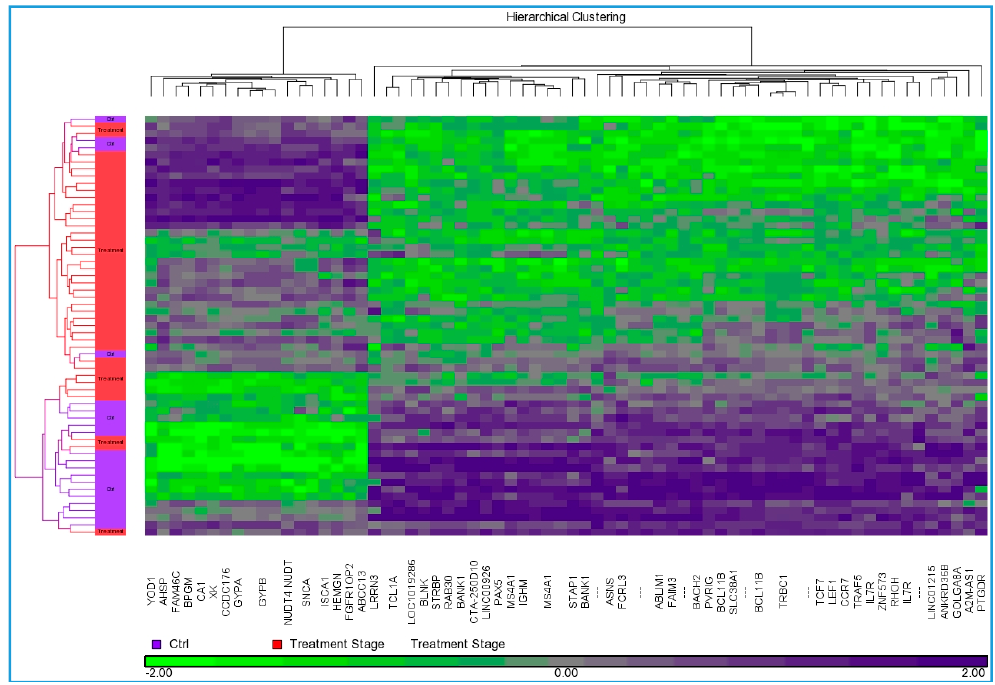
Figure 1. Agglomerative average-linkage hierarchical clustering for differentially expressed genes between radiation treatment stage and controls. Dendrogram obtained using Partek GS 6.6 software shows the change in expression levels of genes ( n = 429, 32-up and 397-downregulated) in RT treated cancer patients compared to untreated controls, Differentially Expressed Genes (DEGs) on X axis and treatment stage on Y axis. The cluster color represents the normalized expression level of a given gene in response to radiation treatment, Purple denotes upregulation and green denotes downregulation according the color scale. Table 1. Top 20 upregulated and differentially expressed genes.